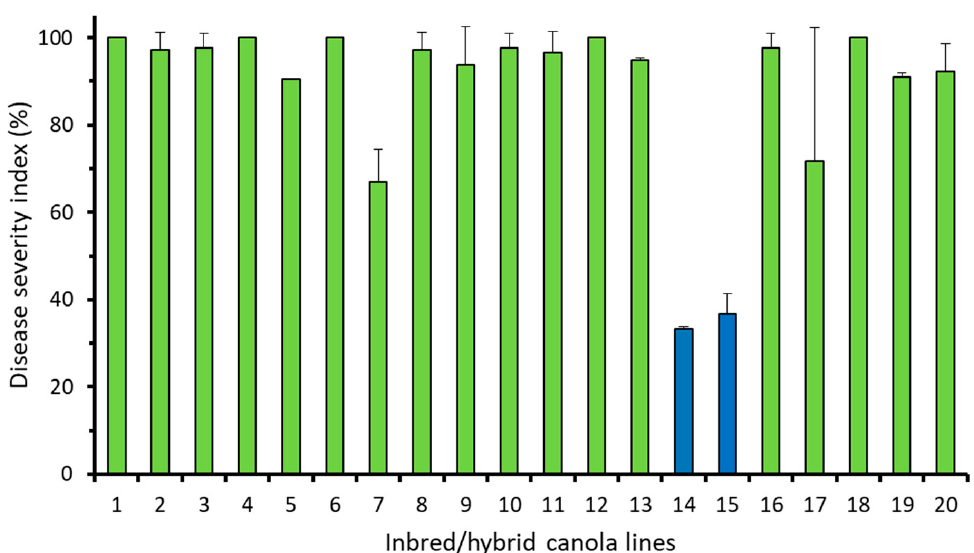
Figure 2. Mean clubroot severity (disease severity index, DSI) in 20 canola lines carrying different numbers or combinations of CR genes in response to L-G3 of pathotype X (data are combined across two repetitions). DSI was substantially lower in lines 14 and 15 (blue bars), relative to others (LSD, p < 0.05), and was 100% in the control cultivars Westar (susceptible) and 45H29 (Mendel-based resistance).